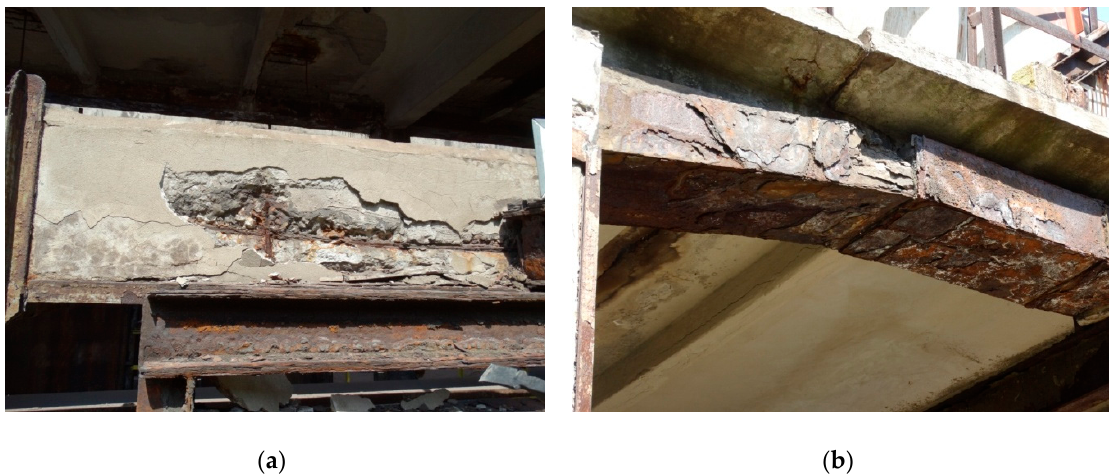
Figure 5. Damage of varying intensity: ( a ) damage of concrete and steel corrosion of rebars and profiles, ( b ) strong corrosion of steel elements used as the strengthening of concrete beams.